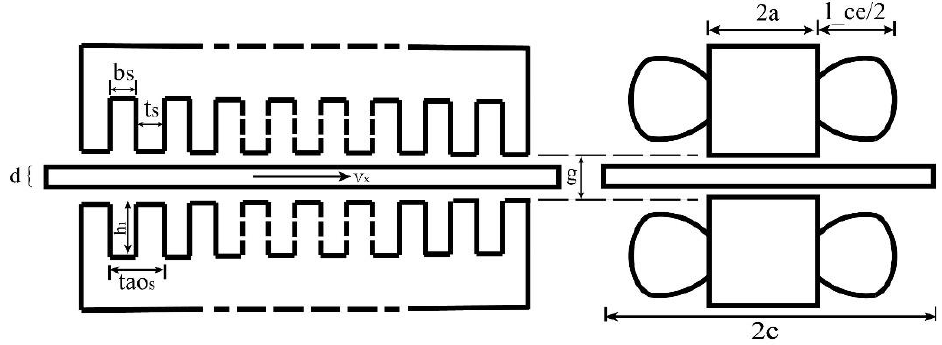
Figure 2. Structure of a SP-DLIM.